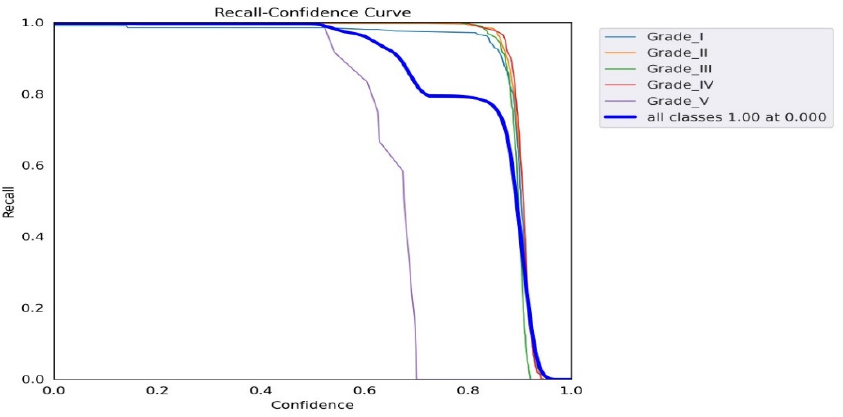
Figure 12. F1 score graph showing the relationship between the F1 and confidence curves.